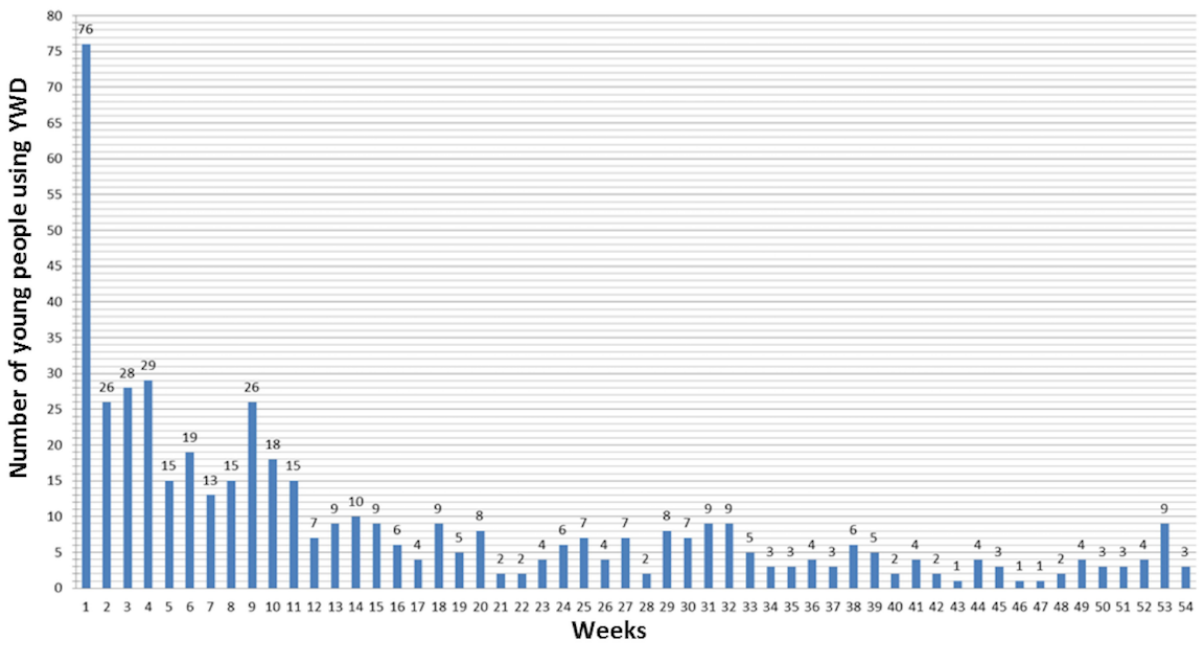
Figure 3. Number of young people who used Young with Diabetes (YWD) during the